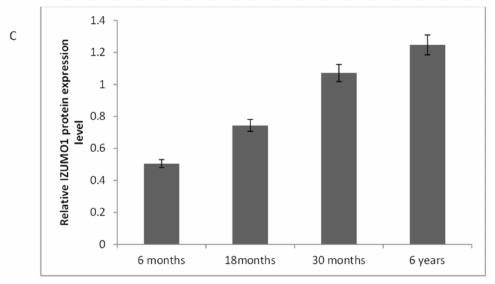
Figure 6. Expression of IZUMO1 protein in Datong yak testis. ( A ) Western blotting for the detection of the expression pattern of IZUMO1 protein in the testis of Datong yak and β eta-actin was used as the internal loading controls ( B ). Relative expression of IZUMO1 protein ( C ).